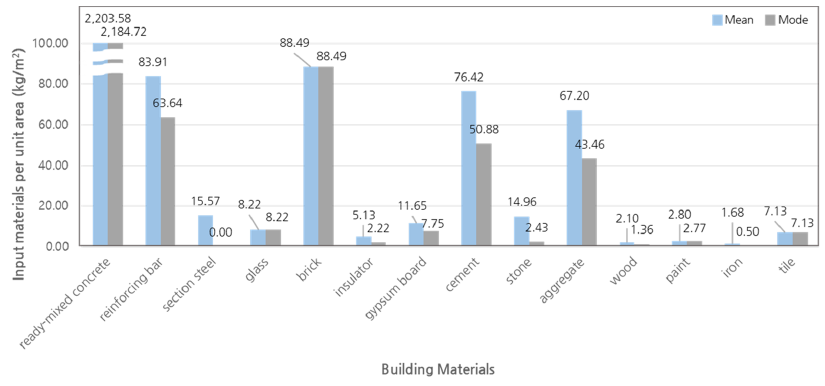
Figure 3. Comparison of mean and mode of building material input quantities.